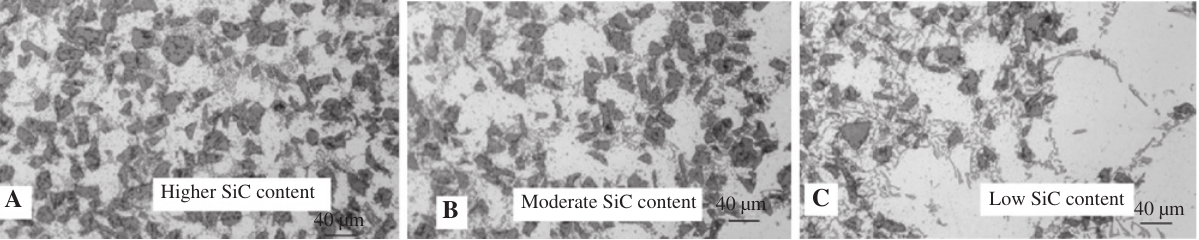
Figure 31: Microstructure of the composite: (A) outer layer, (B) middle layer, and (C) inner layer